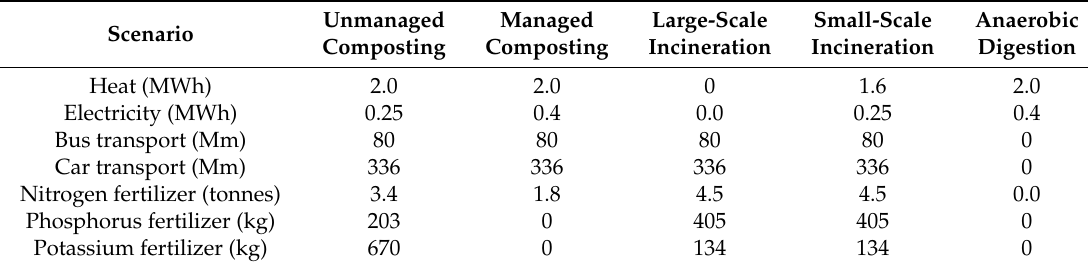
Table 2. Fulfilment of functional units in the scenarios.